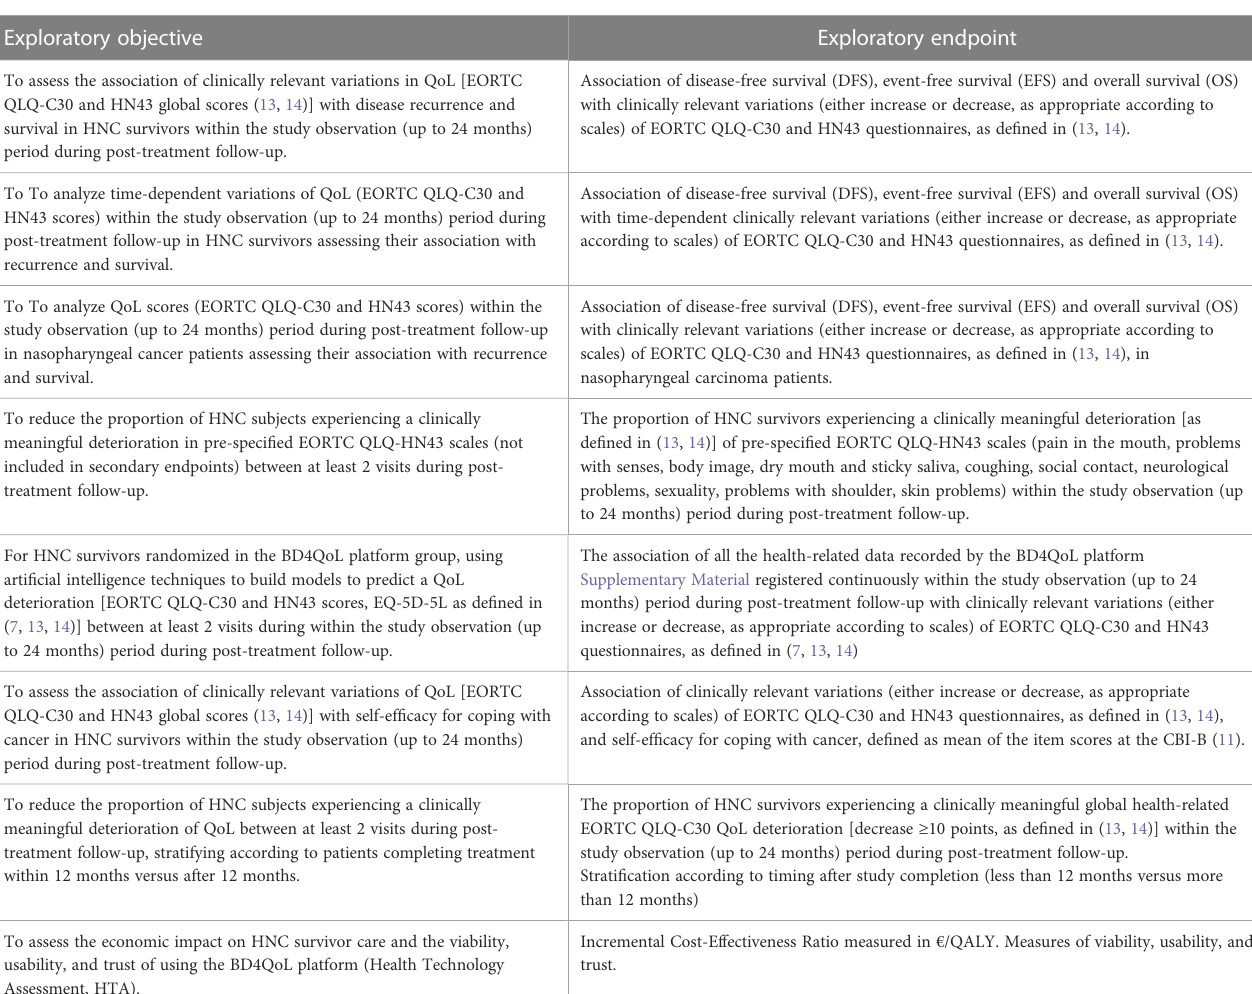
TABLE 2 Exploratory objectives and